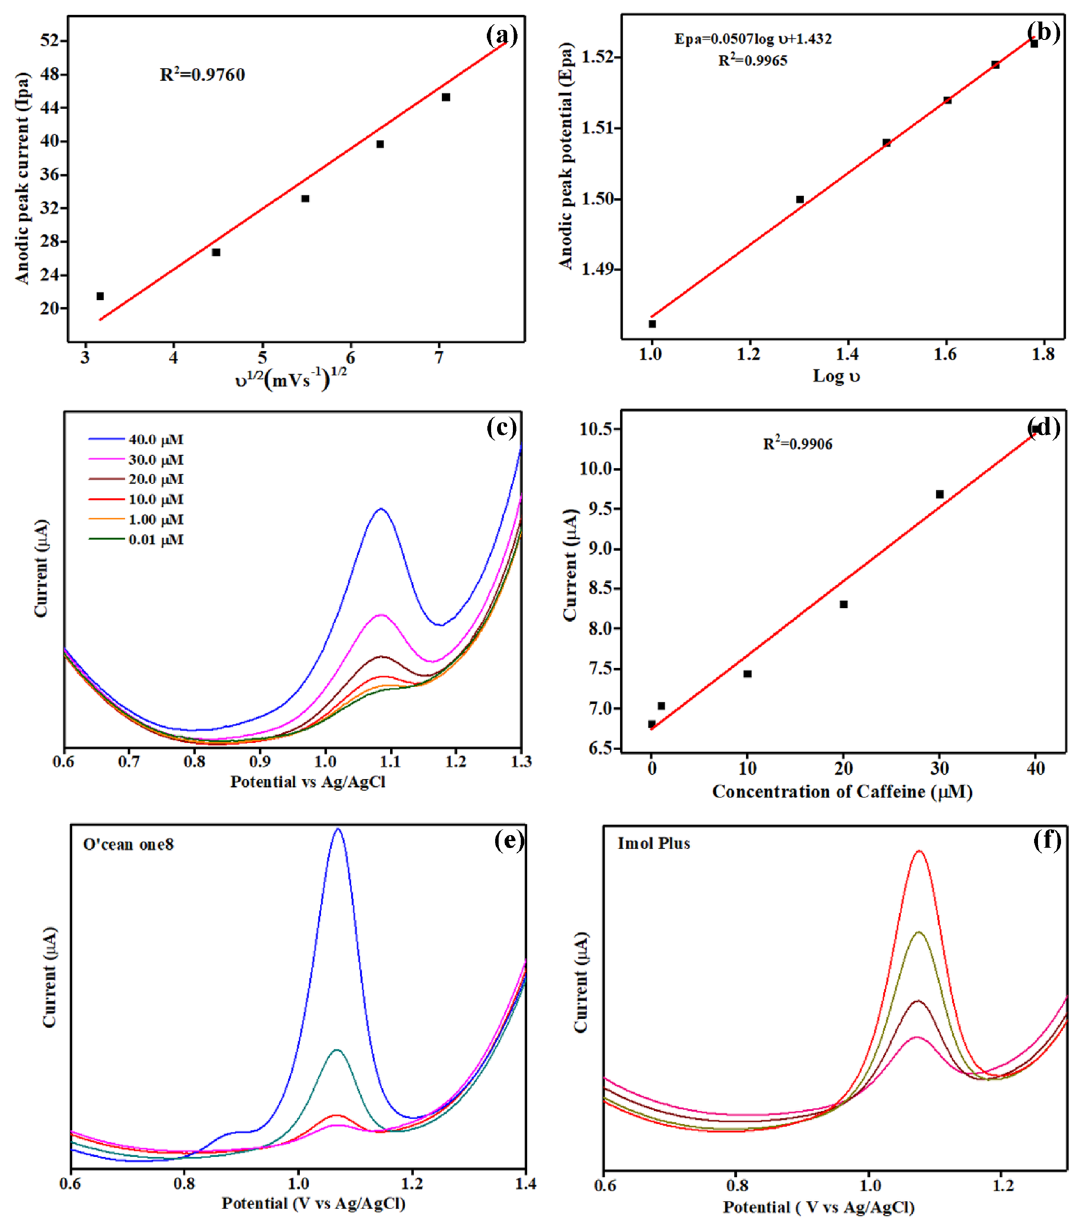
Figure 5. Calibration plot of ( a ) the square root of the scan rate (υ ½ ) vs. anodic peak current (Ipa) and ( b ) logarithm of scan rate (log υ) vs. anodic peak potential (Epa), ( c ) Differential pulse voltammogram (DPV) of the NAHGO modified GCE electrodes at a pH value of 2 with standard additions of caffeine in the